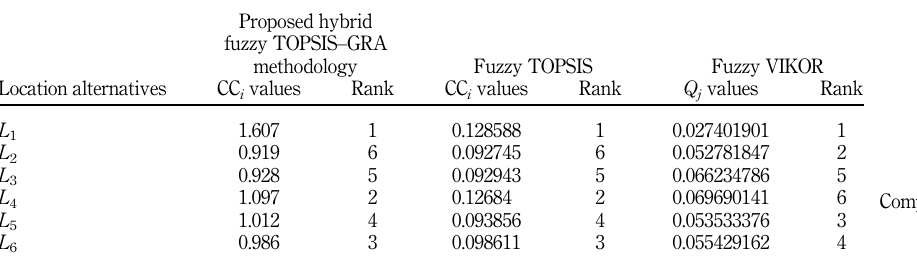
Table 6. Comparative results